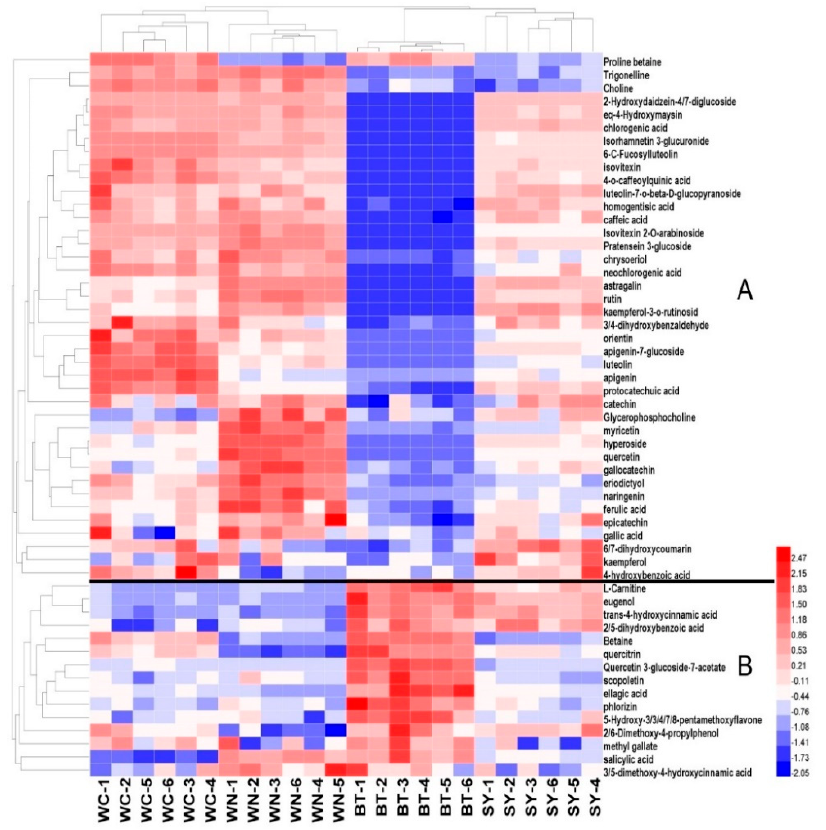
Figure 4. Heat map and hierarchical clustering analysis (HCA) of tea polyphenol and alkaloid contents of Hainan partridge tea from four origins (SY, WN, WC, and BT). According to the HCA diagram, the metabolites can be divided into two categories: ( A , B ).